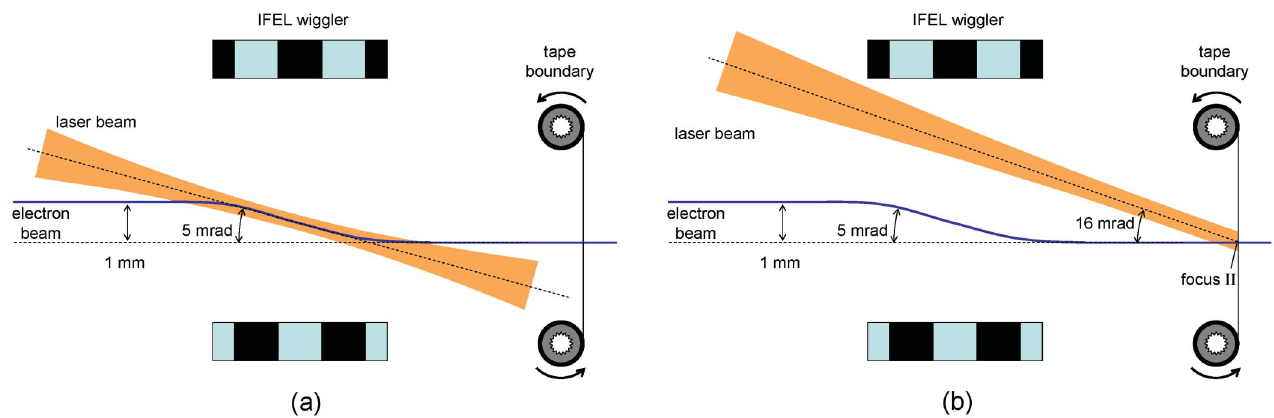
FIG. 6. (Color) (a) laser beam alignment configuration for the IFEL operation and (b) the tape boundary operation. The location of the laser beam focus was adjusted by a sliding telescope. The transverse dimensions in the figures are exaggerated. The IFEL gap was 2 mm and the distance of the center of the IFEL gap to the tape boundary was 10 cm.